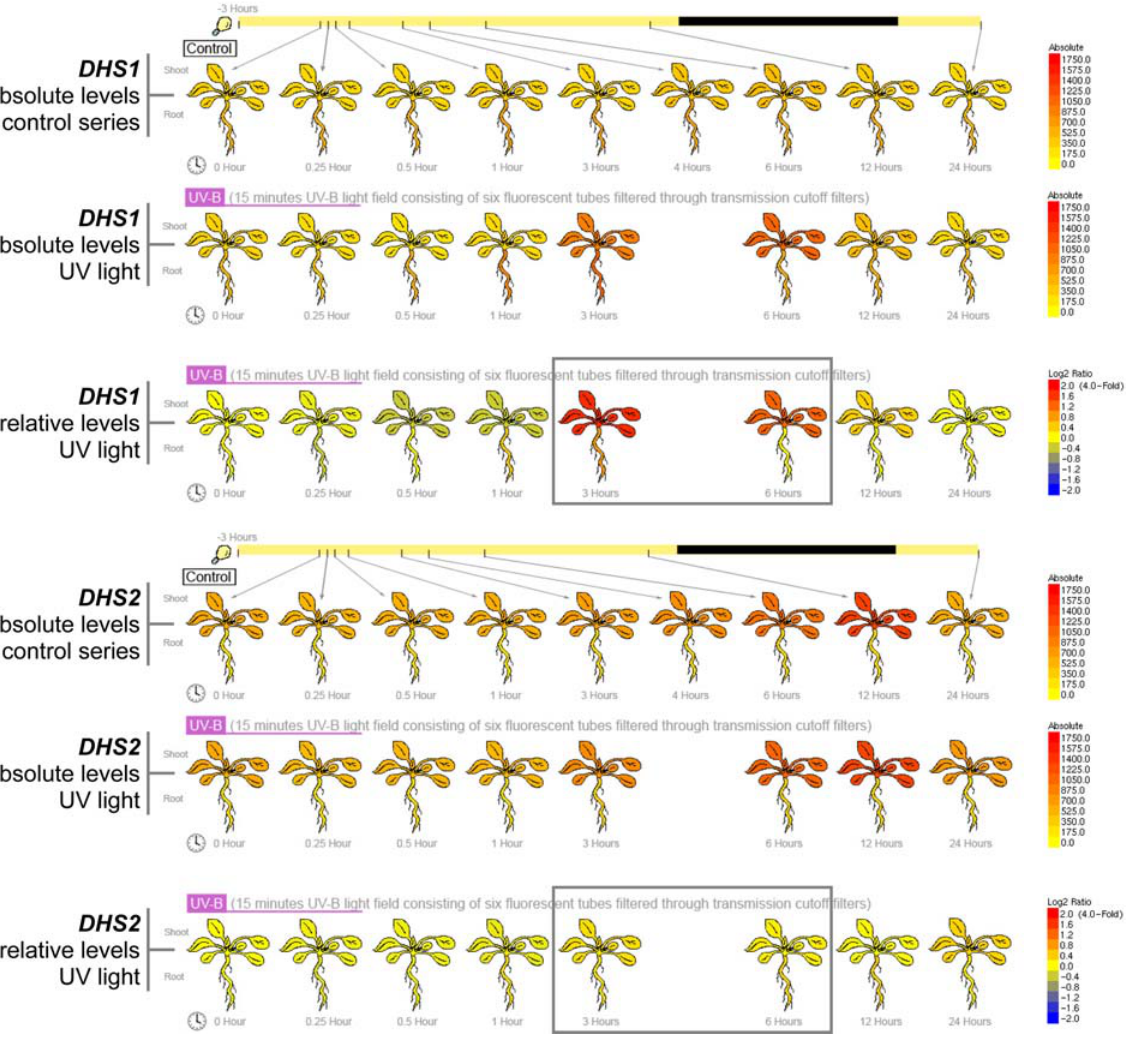
Figure 6. Absolute and relative expression patterns of expression for DHS1, At4g39980, and DHS2, At4g33510. DHS1 is strongly induced by UV light treatment, while DHS2 is diurnally responsive but not UV-inducible per se , see boxed timepoints.